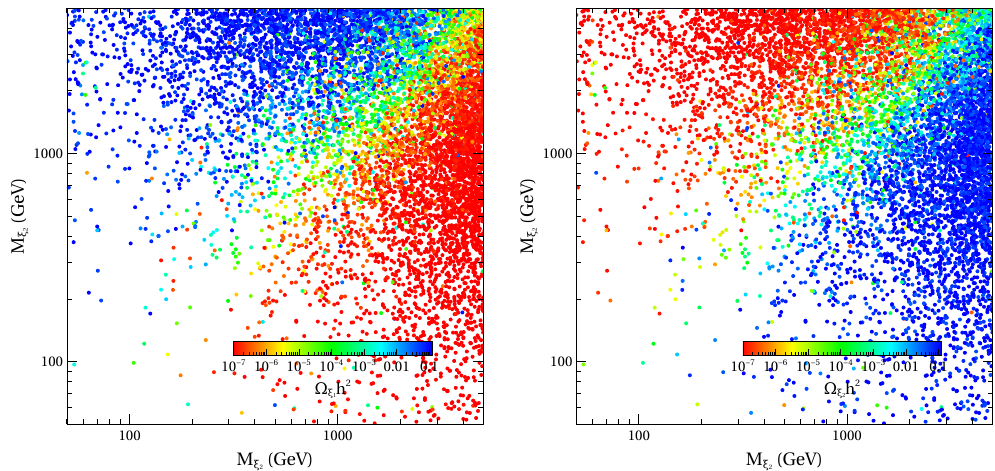
Figure 7 . Scan plot showing the parameter space in M (cid:24) abundance, perturbativity, bounded from below criteria of the scalar